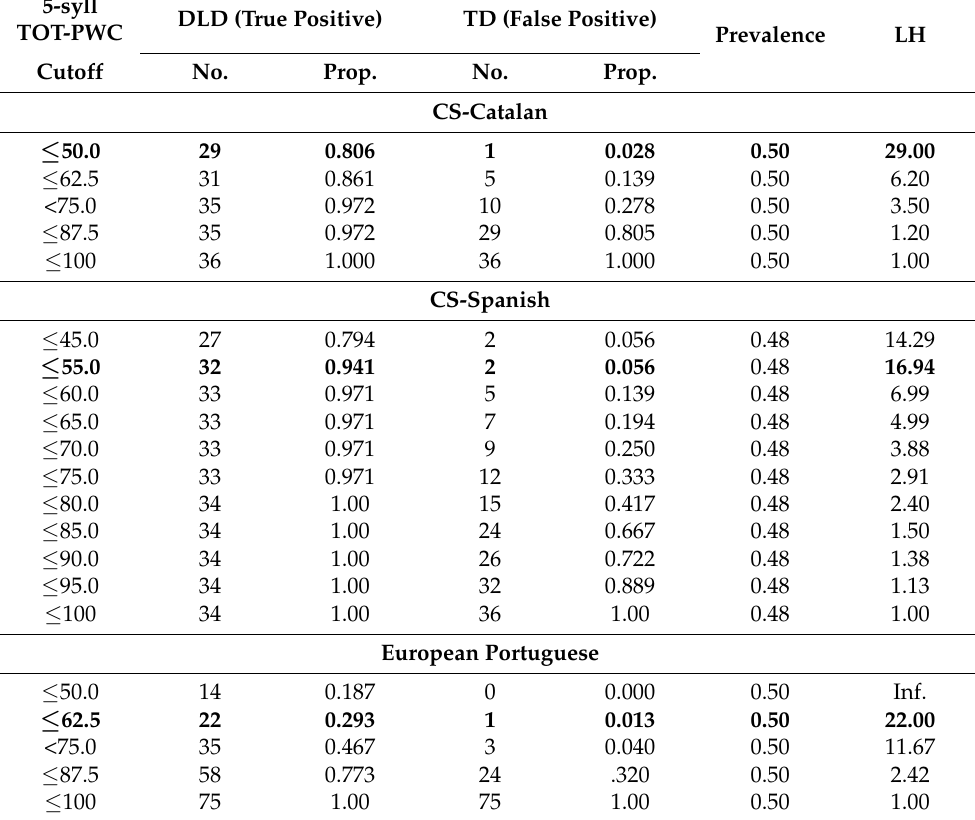
Table 10. The number and proportion of children with a positive test result (ruling in disorder), prevalence and likelihood ratio (LH) for each of the cutoff value based on total word percentage correct (TOT-PWC) for 5-syllable length nonwords for the Catalan–Spanish (CS) and European Portuguese (EP) children with developmental language disorder (DLD) and typically developing (TD) controls. 5-syll DLD (True Positive) TD (False Positive) TOT-PWC Prevalence LH Cutoff No. Prop. No. Prop. CS-Catalan ≤ 50.0